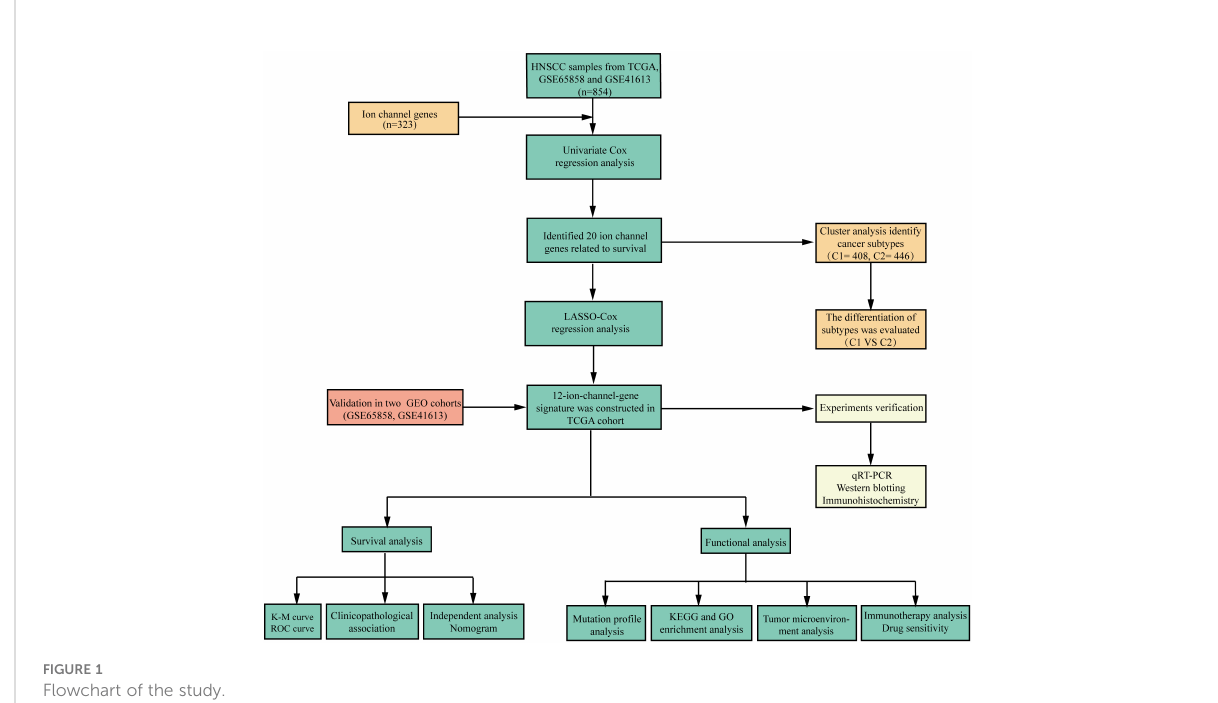
FIGURE 1 Flowchart of the